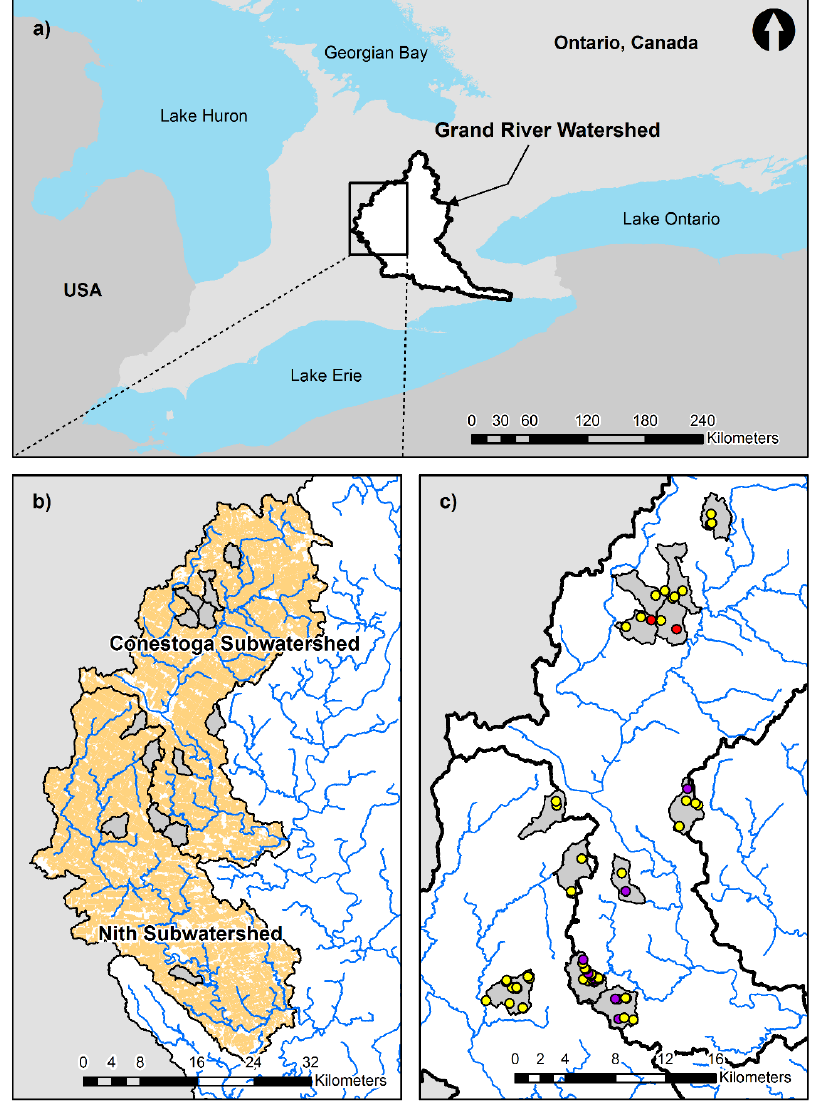
Figure 1. Map showing the location of the Grand River Watershed within the Great Lakes region of North America ( a ); and locations of the 13 headwater study catchments (grey) within the Nith and Conestoga subwatersheds of the Grand River Watershed ( b ). Map showing examples of the distributions of analyzed BMPs (Yellow: manure storage structure, Purple: livestock access restriction fence, and Red: erosion control structure) within study catchments ( c ). Orange surface areas represent agricultural land use.